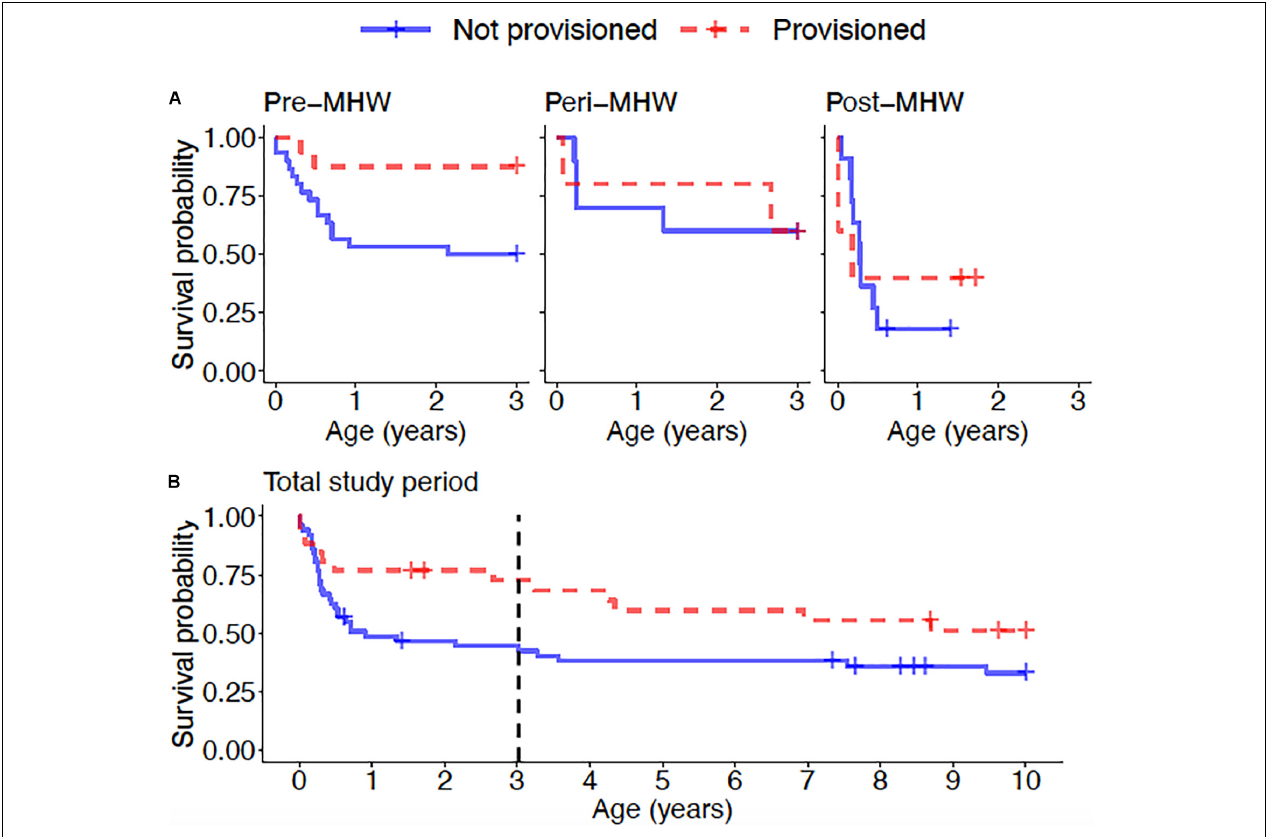
FIGURE 6 | (A) Calf survival for offspring of provisioned and non-provisioned seagrass specialists born in the pre (1994–2010), peri (2010–2015), and post (2015–2019) MHW periods and (B) juvenile survival for offspring of provisioned and non-provisioned seagrass specialists born throughout the study period (1994–2019). Across the whole study period, offspring of provisioned mothers had higher survival to age three than offspring of non-provisioned mothers ( p = 0.031). For offspring of both provisioned and non-provisioned females, survival to age three declined in the post-MHW period ( p = 0.003). Across the total study period, there is no significant effect of provisioning on survival to age 10 ( p = 0.09), suggesting that the benefits of provisioning to offspring do not persist after weaning. The black dotted line denotes age 3, the end of the calf period, after which the difference in survival between offspring of provisioned and non-provisioned females